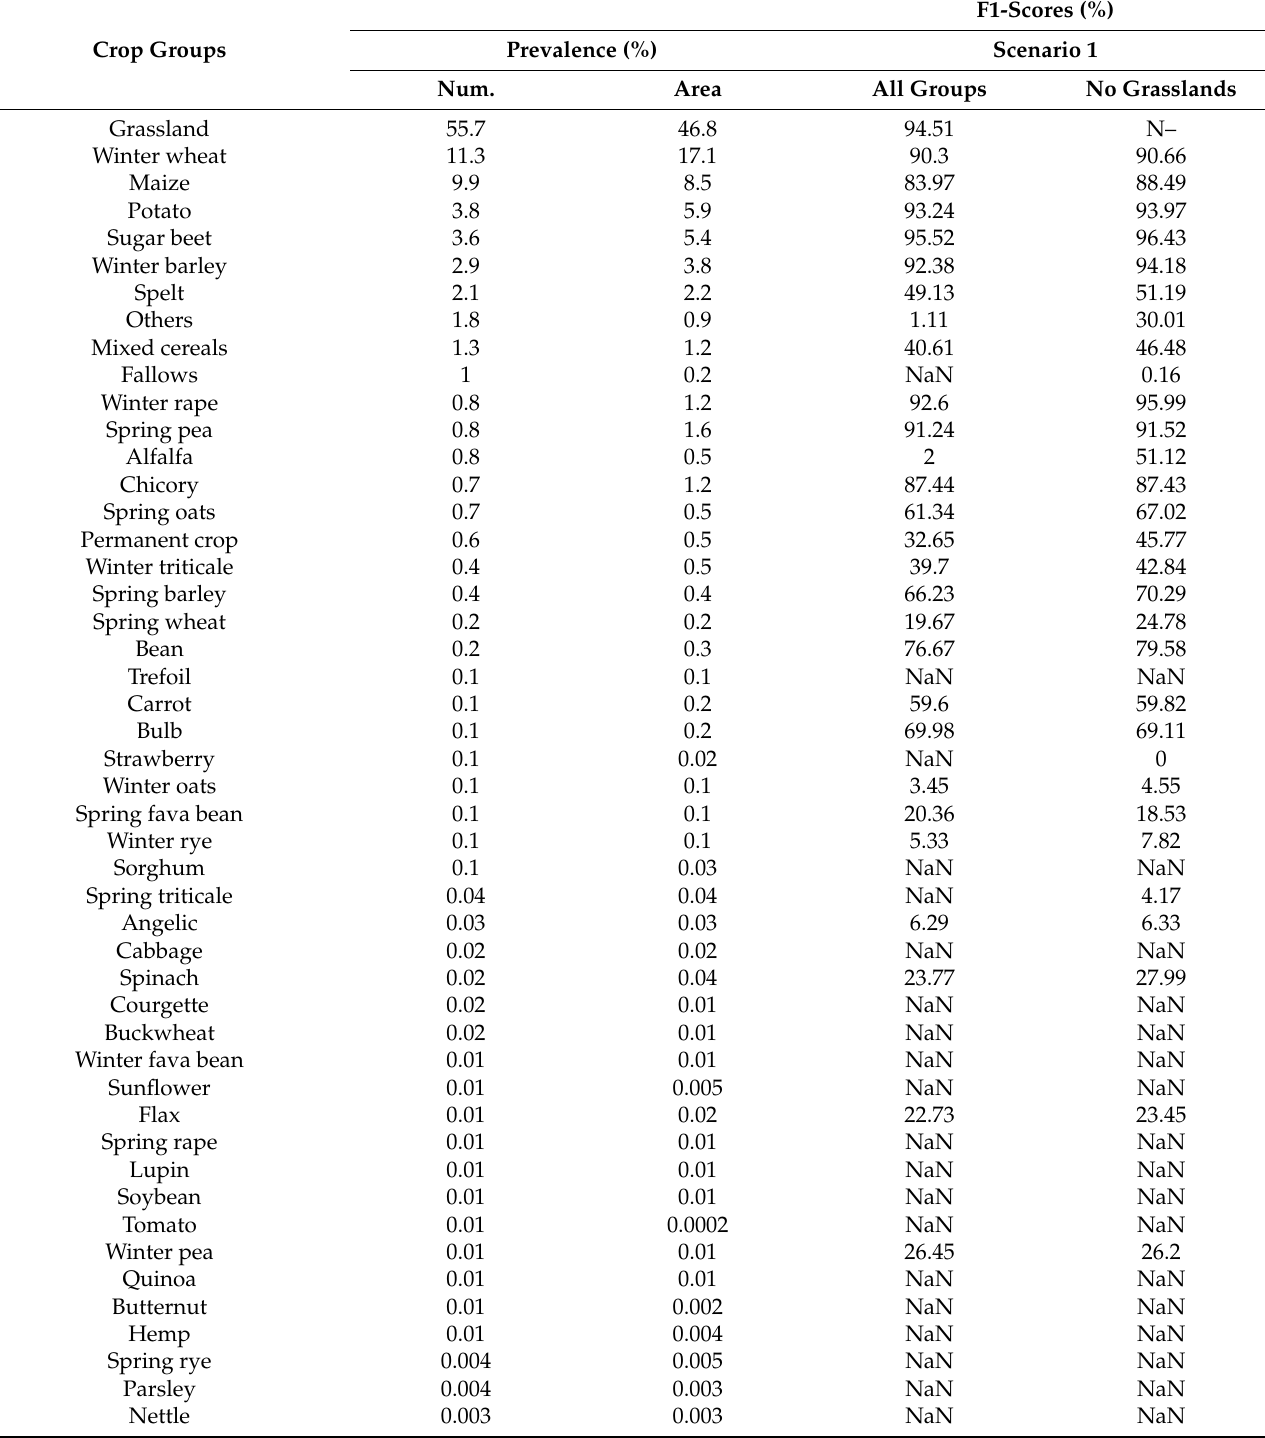
Table 5. F1-score obtained per crop group when considering all crop groups, including grasslands (left), and when considering arable lands only (excluding grasslands) in the training and validation datasets